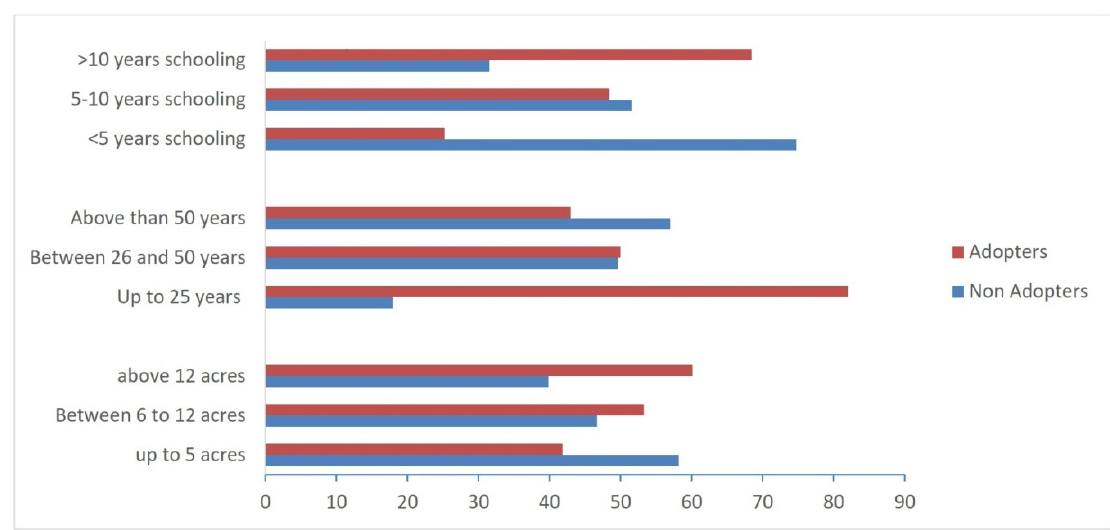
Figure 6. Relationship between adaptation and socio-demographic properties.